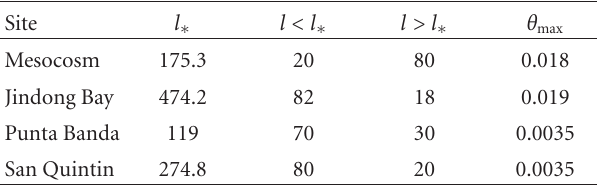
Table 3: Values of the leaf length threshold l ∗ using the values of parameters a , b , and c , fitted at each site. Percentages of l < l ∗ and θ l > l ∗ and values of max for all sites.